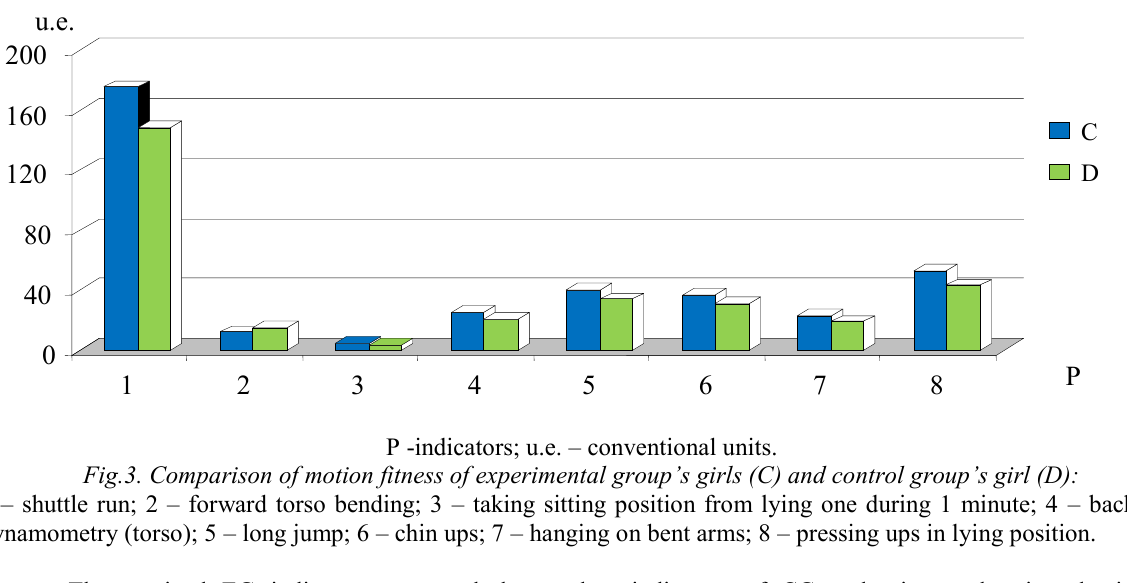
- СГ 0,1 - ОГ Fig.2. Graphic analytical model of motion fitness of health related (SHG) group’s girls and sport group’s (SG) girls: 1 – shuttle run; 2 – forward torso bending; 3 – taking sitting position from lying one during 1 minute; 4 – backbone dynamometry (torso); 5 – long jump; 6 – chin ups; 7 – hanging on bent arms; 8 – pressing ups in lying position. Analysis of aerobic trainings’ influence on girls’ motion fitness showed that in EG it improved by 37%, and in CG – by 23% (see fig.3).